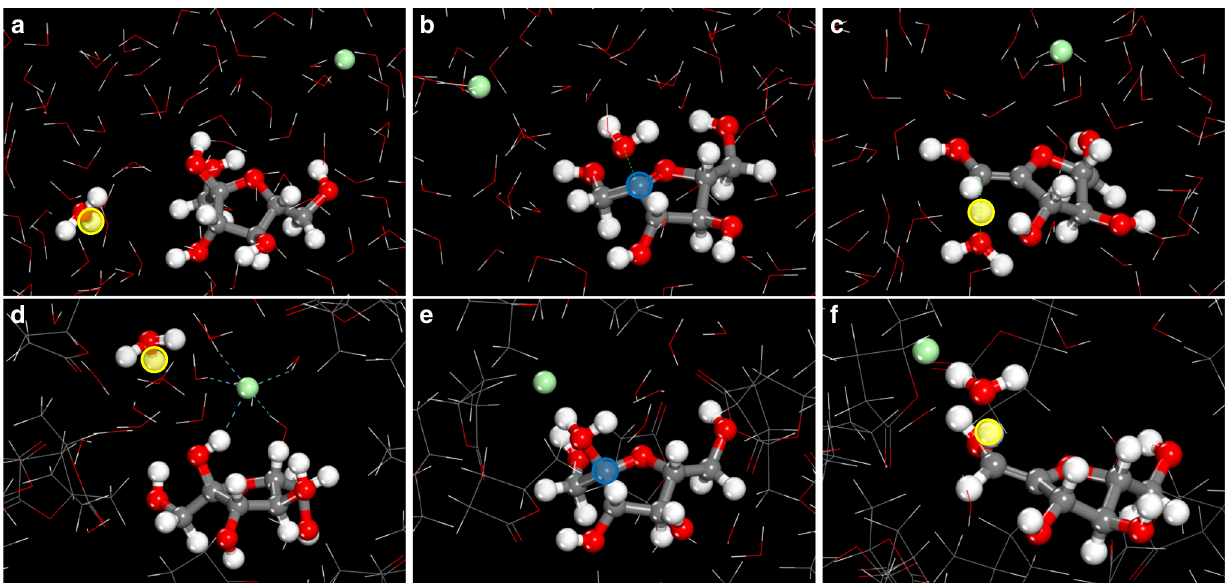
Fig. 4 Fructose dehydration reaction structures. Structures along the reaction path for fructose dehydration carried out in water and HCl mixtures ( a – c ) and in 90% GVL/10% H 2 O (w/w) and HCl mixtures ( d – f ). The structure in the fi rst ( a , d ), second ( b , e ), and third ( c , f ) columns refers to fructose along with H + and Cl − in their reactant state in solution, the resulting oxocarbenium ion from the initial protonation of the C2 hydroxyl group and the elimination of water, and the transition state for the deprotonation of the oxocarbenium ion to form the enol product, respectively. Red, gray, green, and white spheres refer to the oxygen, carbon, chlorine, and hydrogen atoms, respectively. The yellow and blue highlighted circles refer to the reactive proton and oxocarbenium ion centers, respectively (additional structures along the path are presented in Supplementary Figure 6 and Supplementary Figure 9)